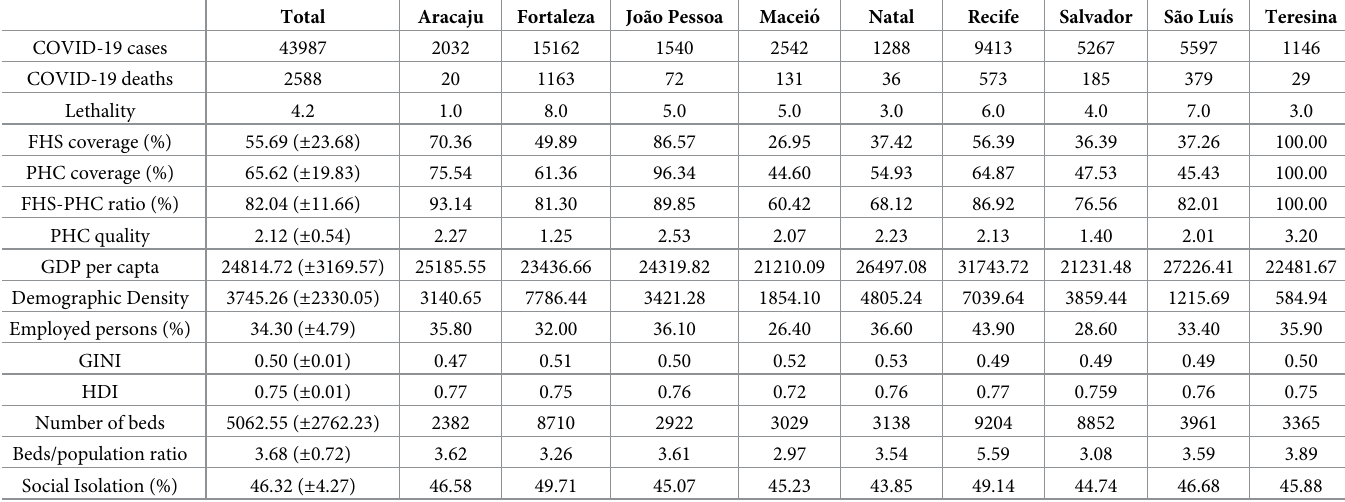
Table 1. Frequency distribution of the contextual characteristics of Northeastern cities in